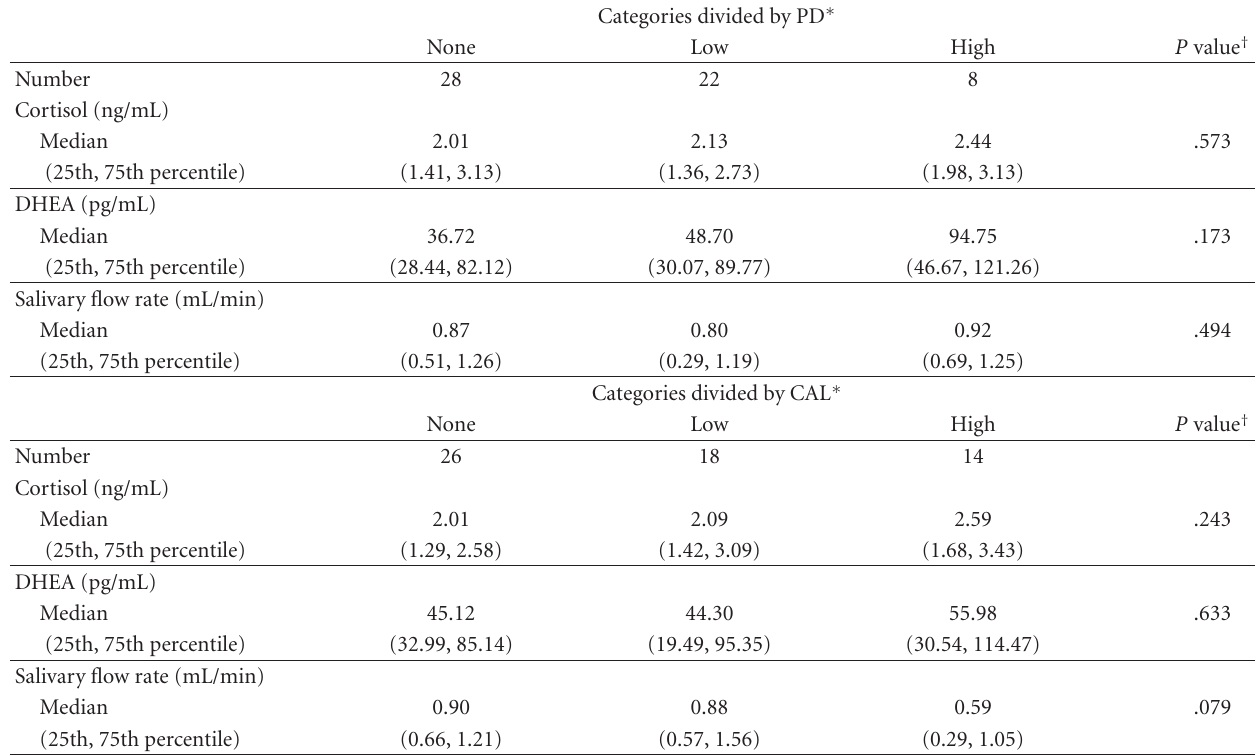
Table 4: Median values for salivary cortisol and dehydroepiandrosterone in presence or absence of extensive periodontitis in subjects who smoked, divided by PD and CAL.